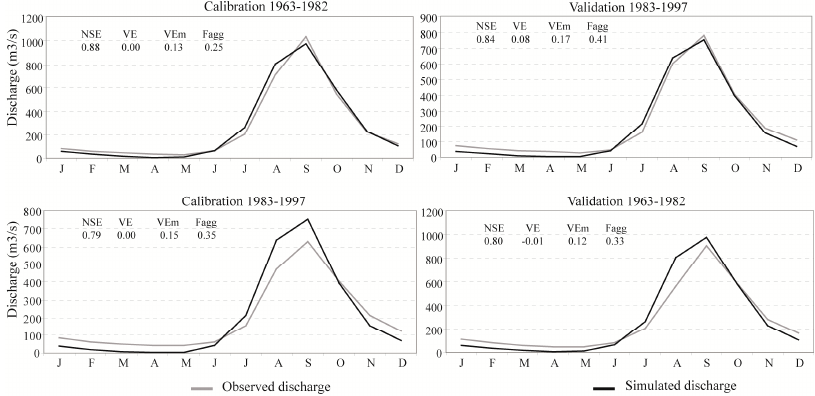
Figure 5. Cross-calibration-validation of the hydrological model (monthly values were calculated from the daily data).